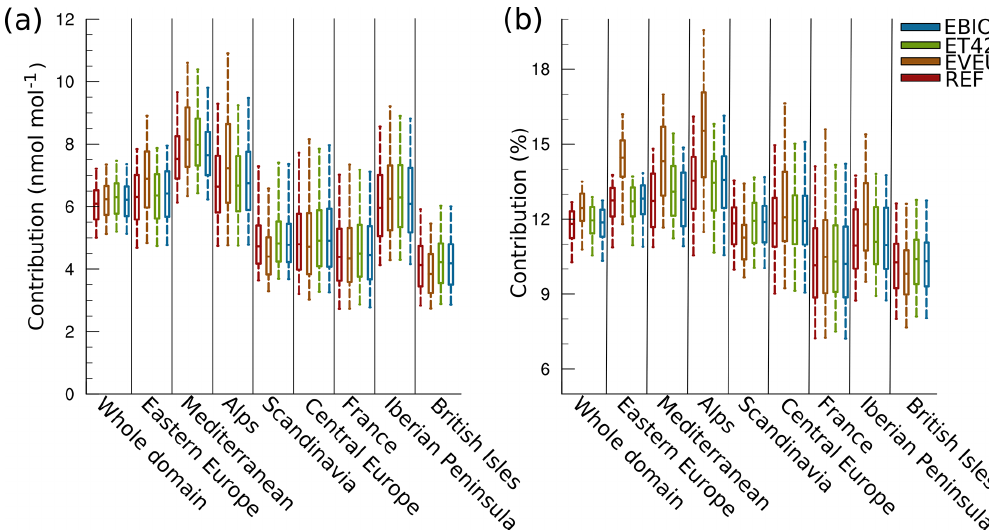
Figure 11. Comparison of the contributions of O tra to ground-level ozone for JJA 2008 between the four simulations. (a) The absolute 3 contribution in nanomoles per mole and (b) the relative contribution to ground-level ozone (in percent). All values are area averaged over the respective region and are calculated using the results of the CM50 instance. The lower and upper ends of the box indicate the 25th and 75th percentile, respectively; the bar indicates the median, and the whiskers indicate the 5th and 95th percentiles of the time series for the JJA values from 2008 based on output every 3h from the